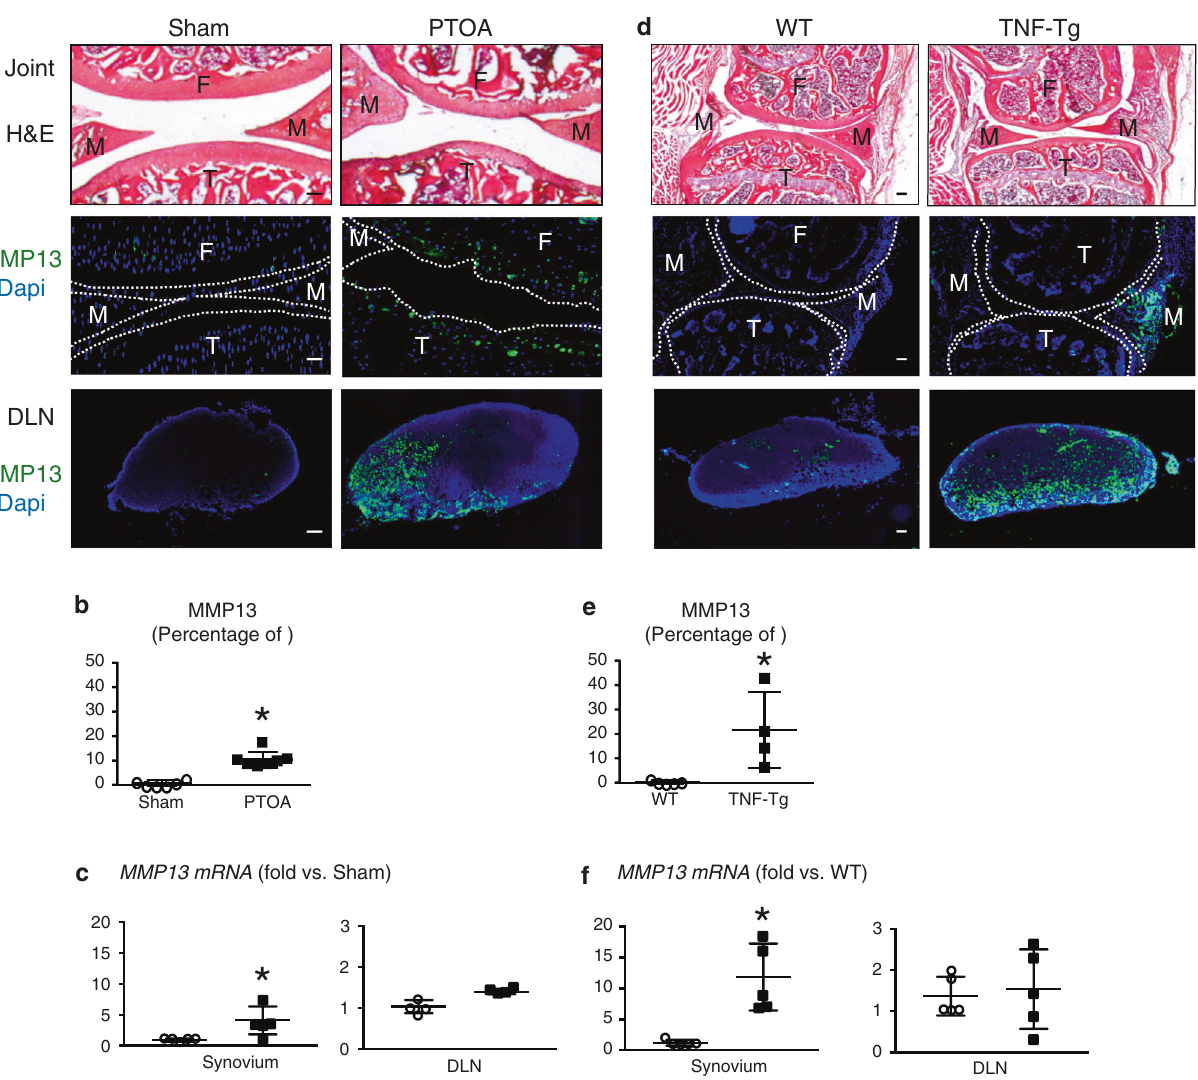
Fig. 6 Arthritogenic MMP13 is removed from osteoarthritic and in fl amed joints via the synovial lymphatic system. C57BL/6J mice received sham or DMM surgery ( a – c ), and TNF-Tg and WT control mice ( d – f ) were used. Knees and DLNs were harvested from operated mice 6 weeks post-surgery ( a – c ) and from 6-month-old WT and TNF-Tg mice ( d – f ). a , d Frozen sections from the knees were H&E stained for light microscopy, and representative 10x images are shown (scale bar = 100 µm). F: femur, T: tibia, M: meniscus. Parallel knee sections (dotted lines indicate the joint space) and DLN sections were immunostained with green fl uorescent labeled antibodies against MMP13, counterstained with DAPI, and representative dark fi eld images obtained at 10x are shown. Note that only articular chondrocytes in PTOA knees, synovium in TNF-Tg knees, and their DLNs, have robust MMP13 immuno-reactivity. b , e VisioPharm histomorphometry was performed to quantify the percentage of MMP13 + area of the DLN immunostained sections, and data are presented for each DLN + / − SD (* P < 0.05 vs. non-arthritic control with paired t -test). c , f Mmp13 mRNA levels in knees were assessed via qPCR. The data are presented for each tissue ± SD (* P < 0.05 vs. non-arthritic control with paired t -test). The content presented in Fig. 6 was derived from a PhD dissertation and was provided by Dr. Xi